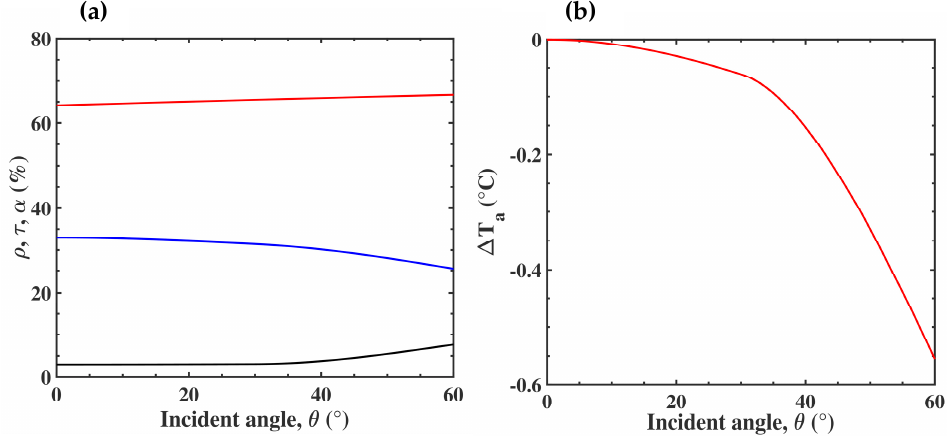
Figure 7. ( a ) Angular dependence of normalized reflectance ρ (black), transmittance τ (blue), and absorbance α (red) in the MIR. ( b ) Evolution of the required ambient temperature to keep T s = 34 °C, as a function of the incident angle, θ .